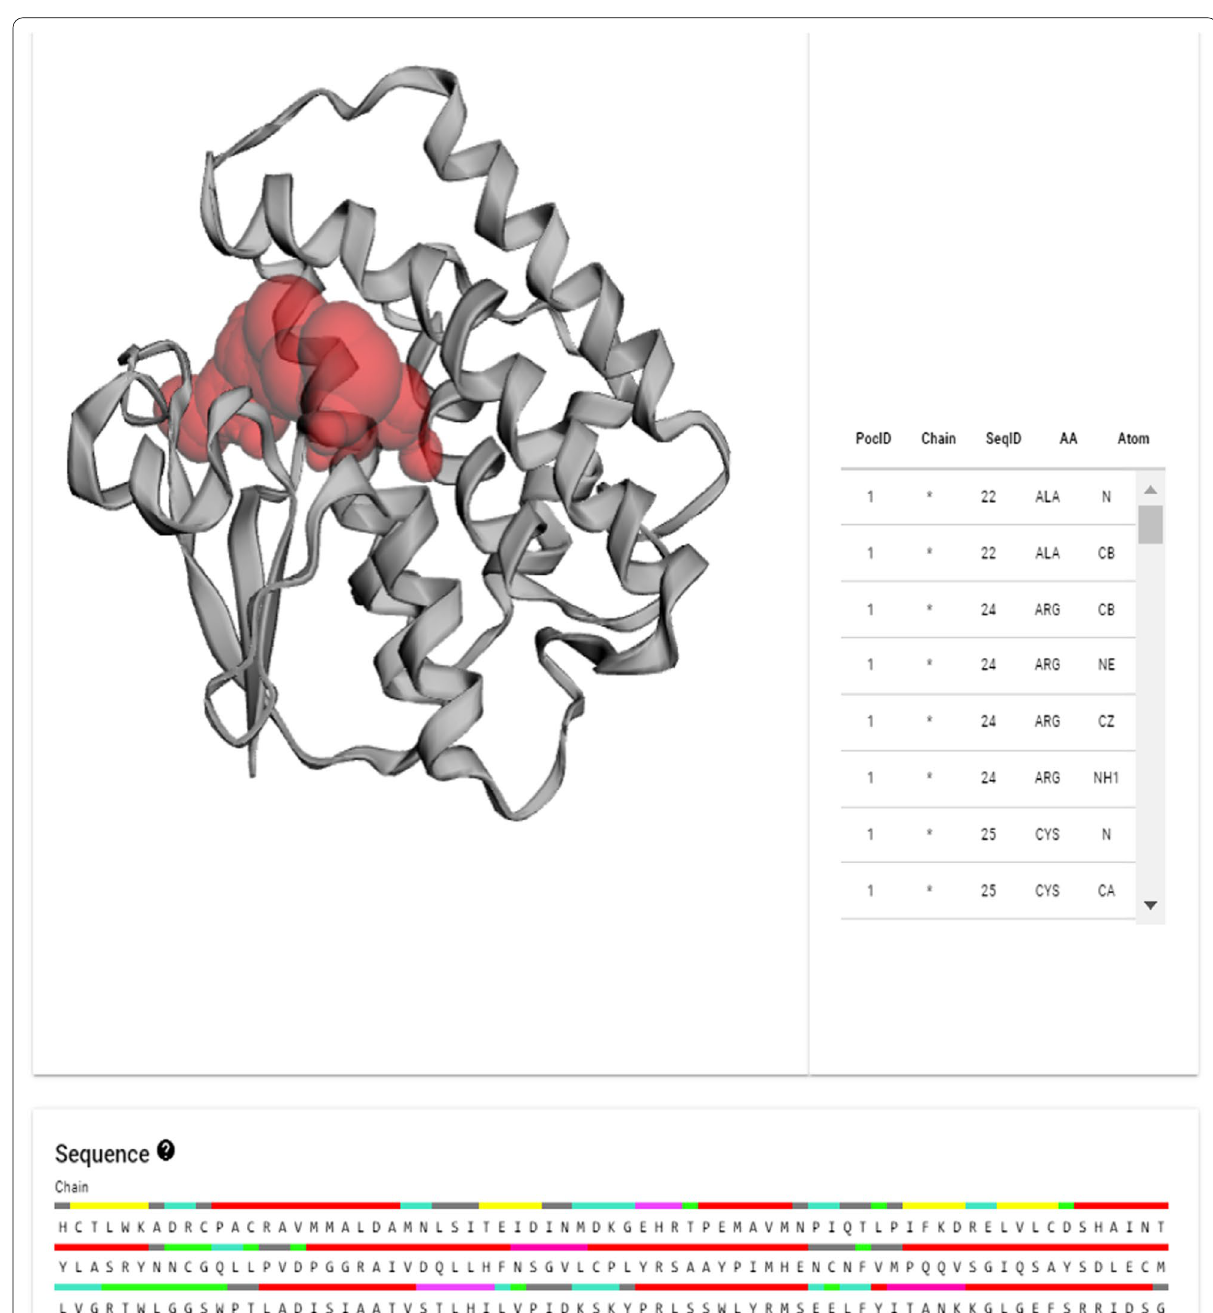
Fig. 12 Active sites of G. mellonella